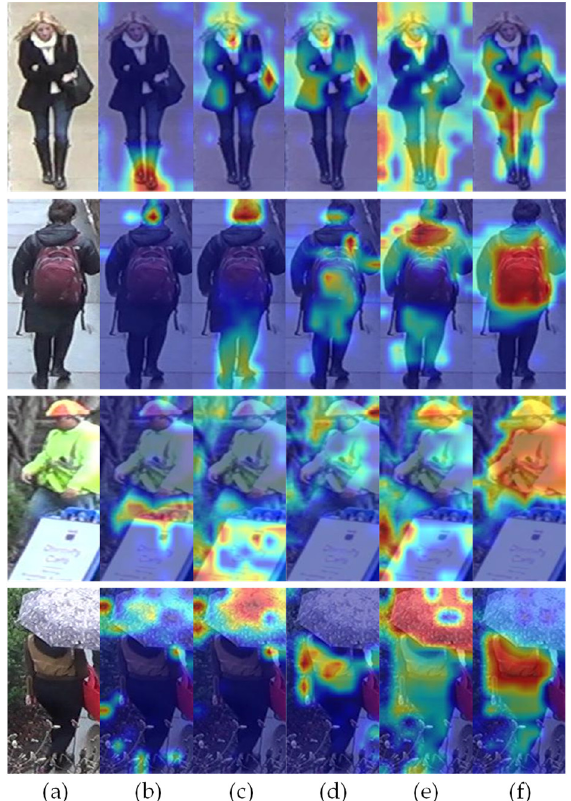
Figure 7. Visualization of models’ attention heat maps. ( a ) Input image, ( b ) CNN-based model, ( c ) ViT-based model, ( d ) SAEM, ( e ) MFTM, ( f ) SAEM + MFTM. The red regions represent a high level of attention by the model, and the blue regions indicate a low level of aention.